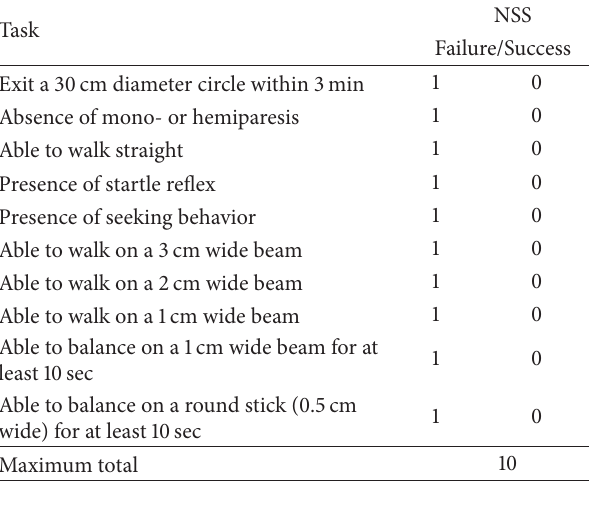
Table 2: Grip test scoring. Figure 1: Time course of cathepsin S (CatS) protein expression in the ipsilateral cortex of mice after traumatic brain injury (TBI). Expression levels of CatS were normalized to those of 𝛽 -actin. The level of CatS protein was significantly increased at 3h and 6 h after TBI. (a) A typical Western blot result. (b) Quantification of data in (a). Data represent mean ± SEM ( 𝑛 = 6 ). ∗∗ 𝑃 < 0.01 , ∗∗∗ 𝑃 < 0.001 versus sham group.